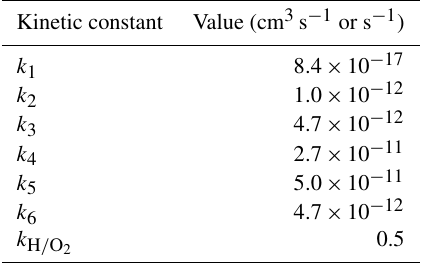
Table A1. Kinetic constants used in the ELVOC kinetic model. Kinetic constant